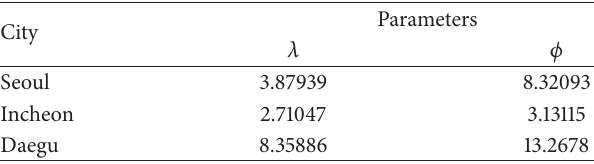
Table 5: Bayes estimates for the parameters, 𝜆 and 𝜙 after omitting the year